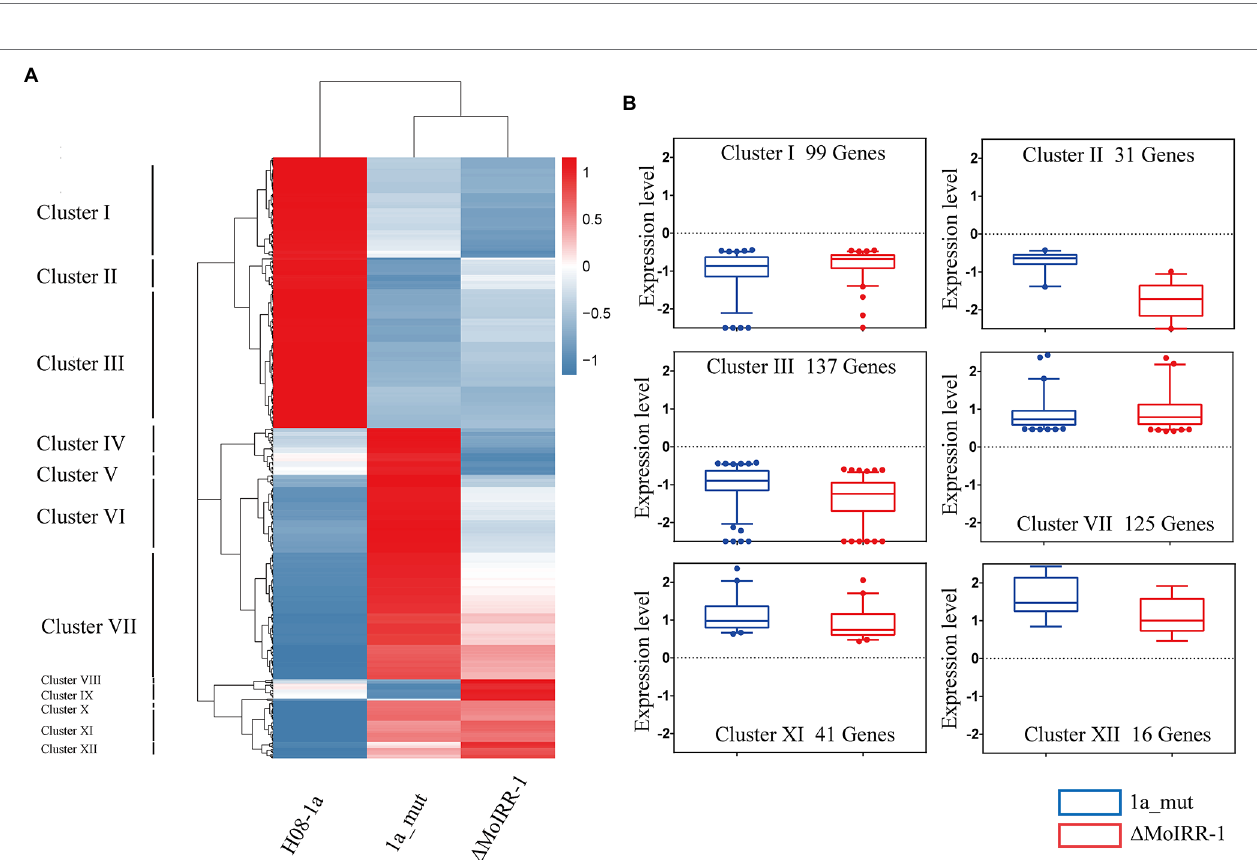
FIGURE 3 | Hierarchical clustering showing expression patterns of DEGs in transcriptomic analysis of 1a_mut and Δ MoIRR-1. (A) Horizontal sample clustering showed that expression profiles of 1a_mut and Δ MoIRR-1 were closer than that of H08-1a. Vertical clustering of gene expression was divided into 12 clusters with multiple expression patterns. Color scale showing the level of gene expression of log 2 (FPKM+1). (B) Box plot exhibiting the similar expression patterns of DEGs in six clusters between 1a_mut and Δ MoIRR-1. There were 9, 31, and 137 DEGs in Cluster I, Cluster II, and Cluster III were simultaneously downregulated in both 1a_mut and Δ MoIRR-1; 125, 41, and 16 DEGs in Cluster VII, Cluster XI, and Cluster XII were simultaneously upregulated in both 1a_mut and Δ